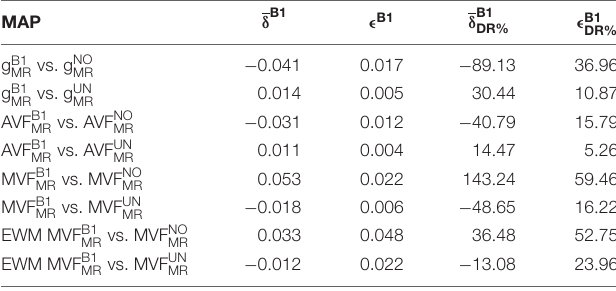
TABLE 4 | Bias and error between methods, in g MR , AVF MR , and MVF MR .